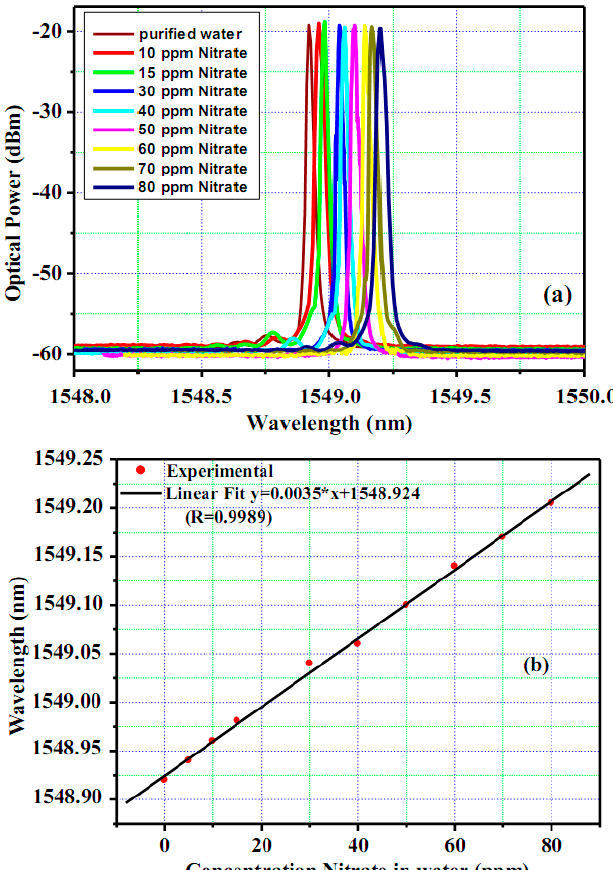
Figure 5. ( a ) Spectral response for different concentrations of nitrate solutions from fiber laser sensor; and ( b ) Bragg wavelength shift as a linear function of nitrate concentrations in water.